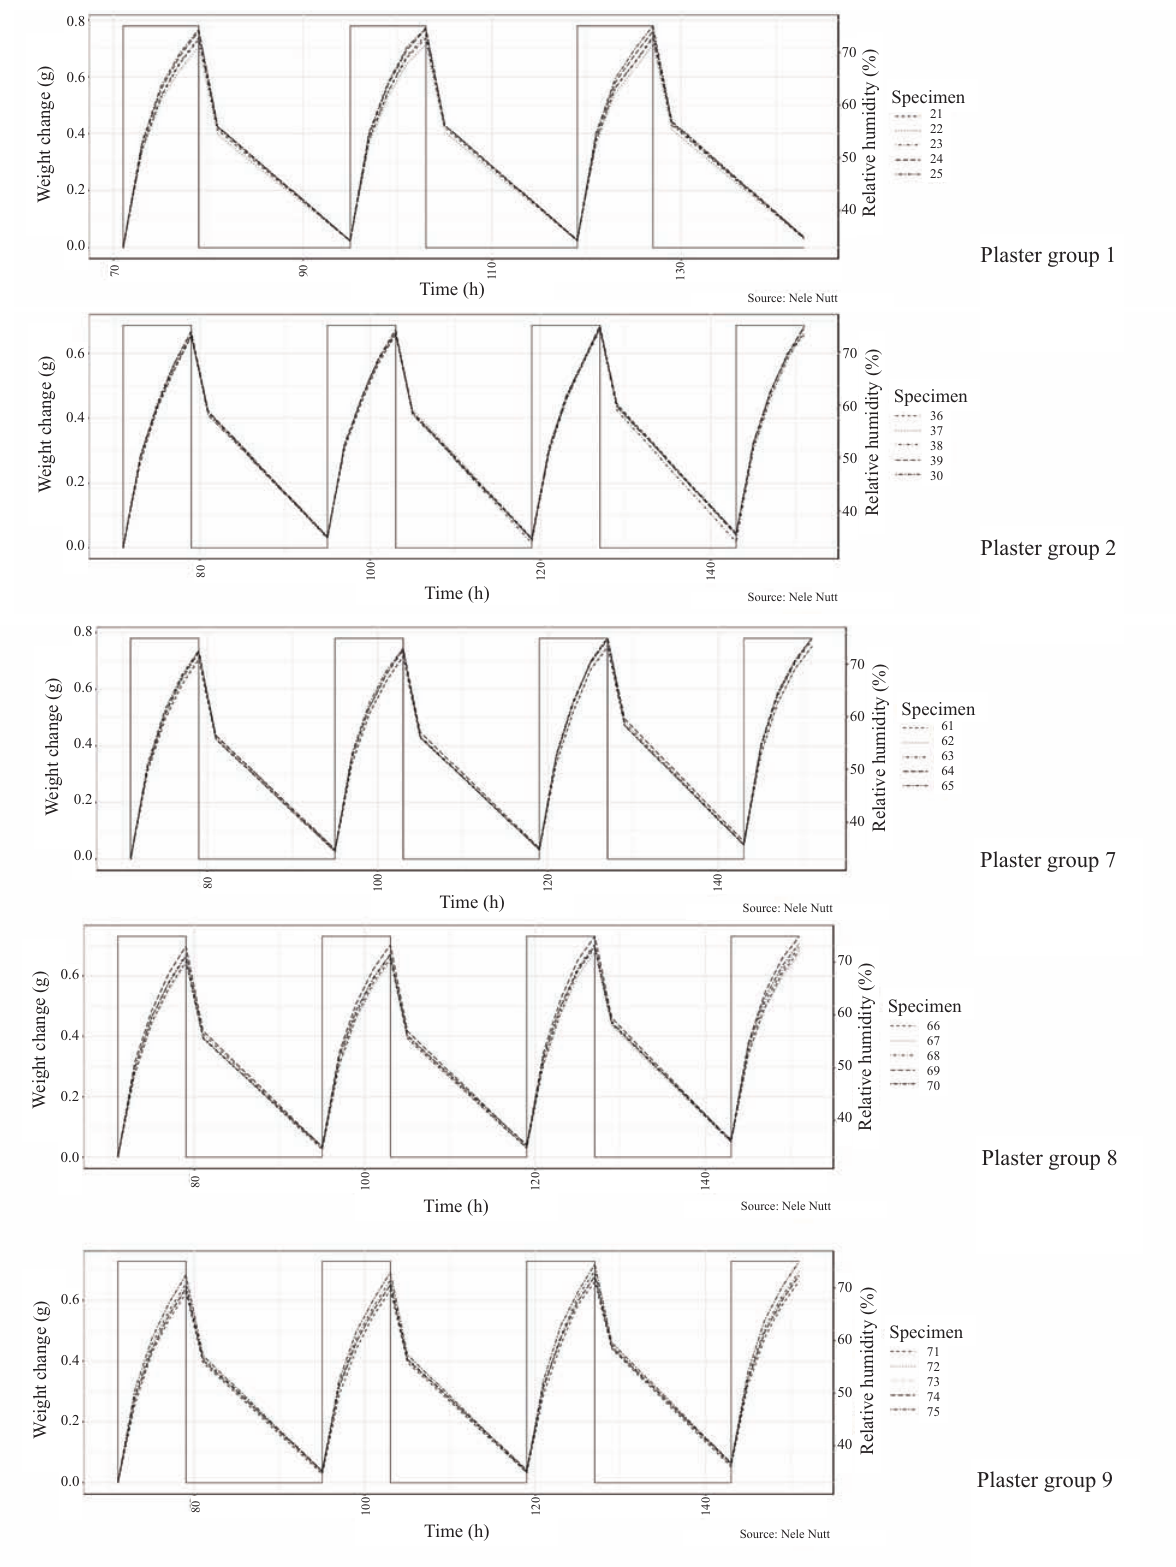
Fig. 3. Changes in specimens’ weight (only weight change) in the final cycles (plaster groups 1, 2, 7, 8 and 9) of Nordtest. The change in moisture cycles (RH 33% and RH 75%) in the climate chamber is portrayed by a continuous